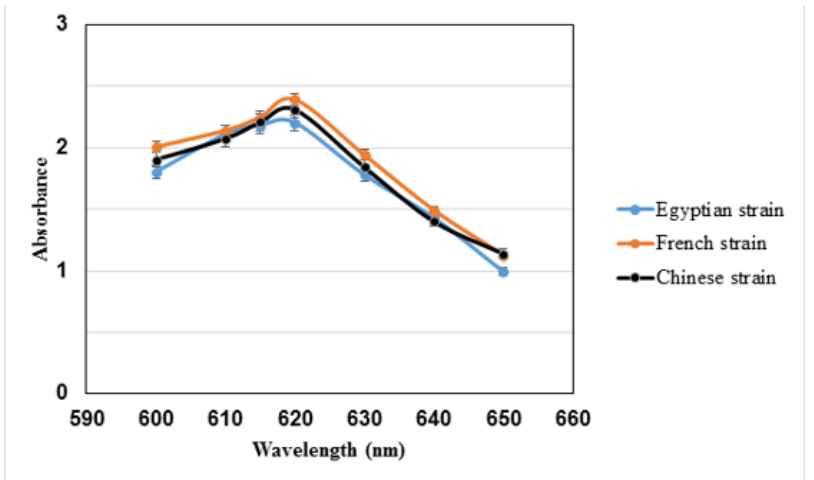
Figure 3. The 12% SDS-PAGE analysis of the extracted C-phycocyanin from dry biomass of the three microalgae strains. M: Protein molecular weight marker; 1, 2: C-phycocyanin extract from the Chi- nese strain; 3, 4: C-phycocyanin extract from the French strain; 5: C-phycocyanin extract from the Egyptian strain. The arrow points to C-phycocyanin subunits.